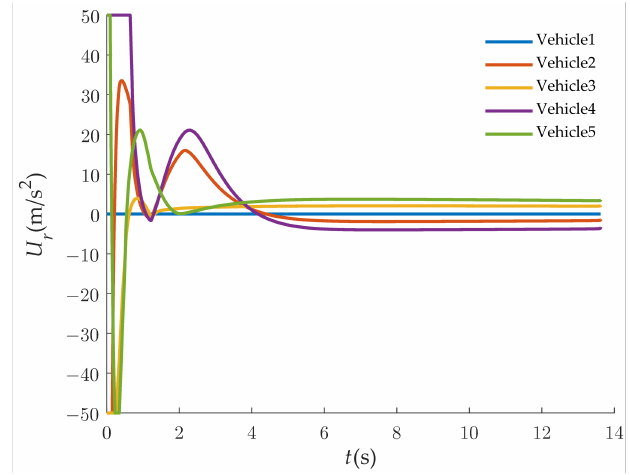
Figure 7. Control commands in LOS